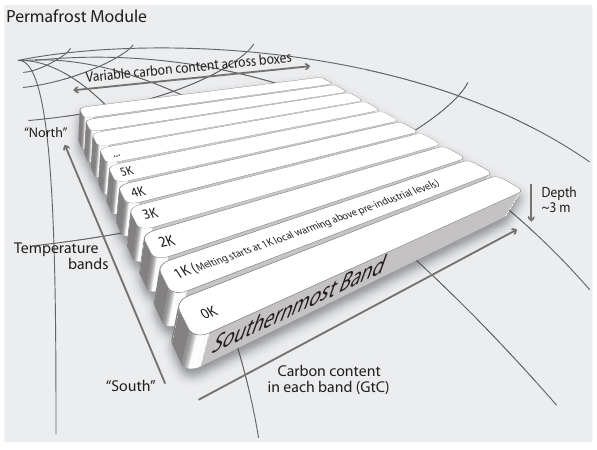
Fig. 1. Schematic overview of the simplified permafrost module with n zonal bands (default n = 50) in which thawing starts at dif- ferent global warming levels. The carbon content of the represented permafrost fractions (approximating upper 3m soil layer) can vary across the different zonal bands of equally spaced temperature in- tervals (default=0.2K spacing), with the default being an initially uniform carbon content distribution. Each zonal band is further sub- divided into four soil pools with differing thaw and decomposition characteristics: mineral and peatland soils, divided into aerobic and anaerobic